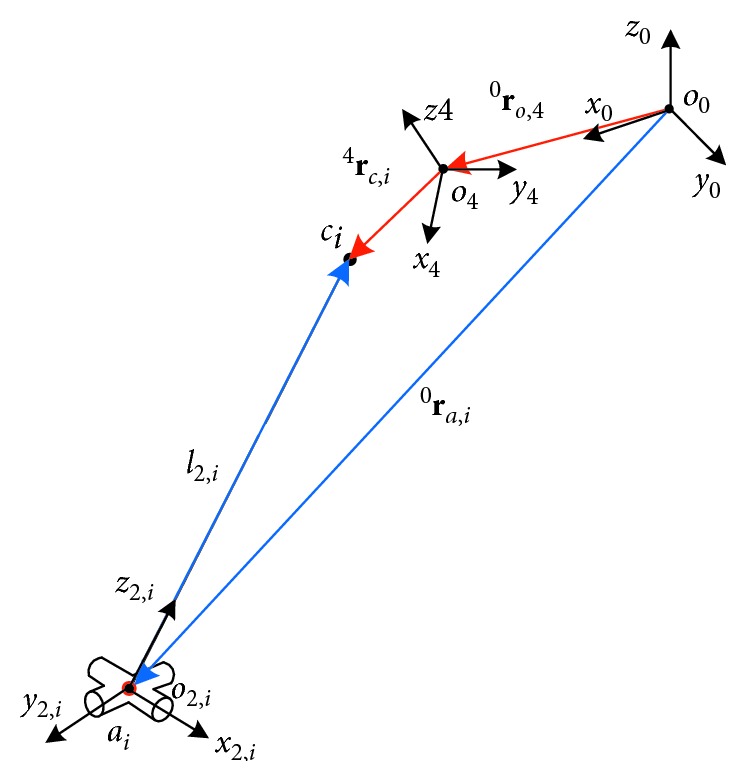
Closed vector loop of UiPiSi.